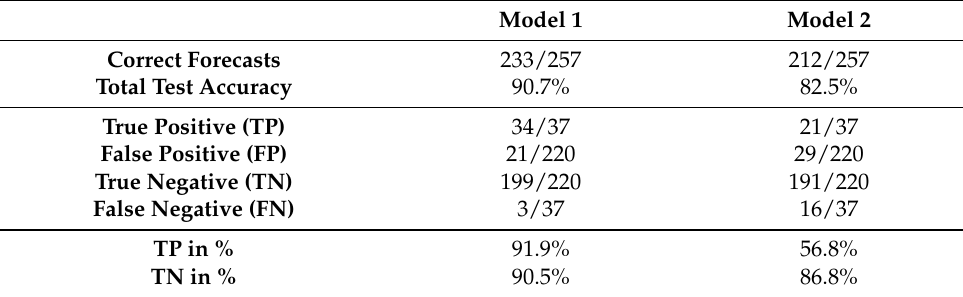
Table 4. Results of the walk-forward forecasting and